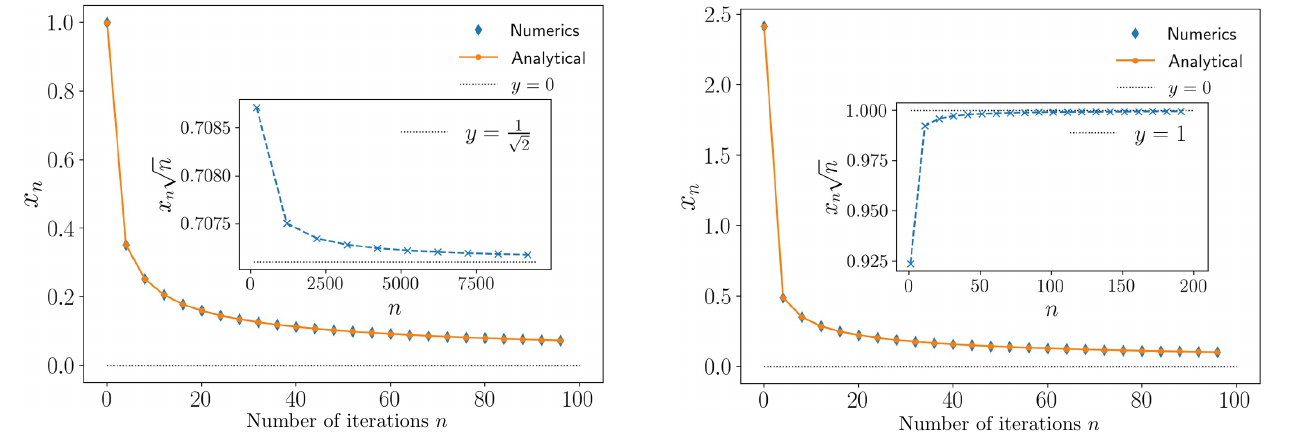
FIG. 14. The XXX case: convergence to the respective fixed point x ∗ = 0 under the map initiated with c ( 0 ) = π/ 8 or, equiv- alently x 0 = 1. The inset shows the power-law behavior for the same initial condition, as seen from the convergence x n √ 2 for large n . 1 /